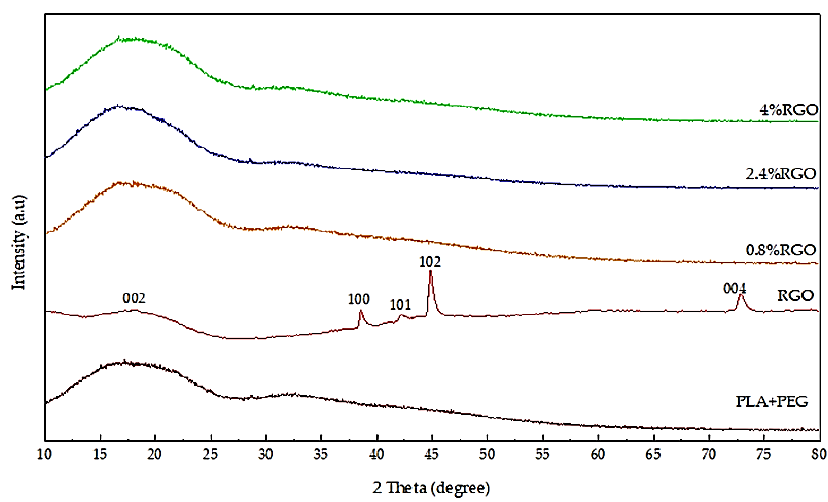
Figure 8. The X-ray diffraction (XRD) patterns of the PLA/PEG mixture, RGO powder, and RGO/PLA/PEG nanocomposites at different percentages of RGO.